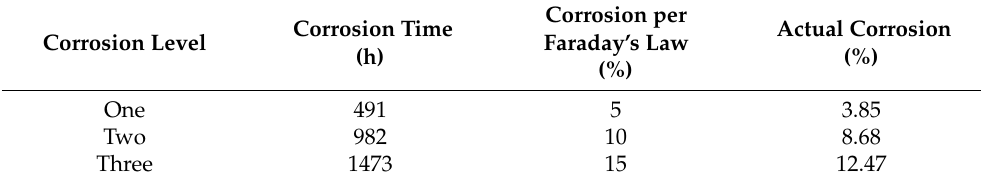
Figure 5. Schematic view of the corrosion test setup.